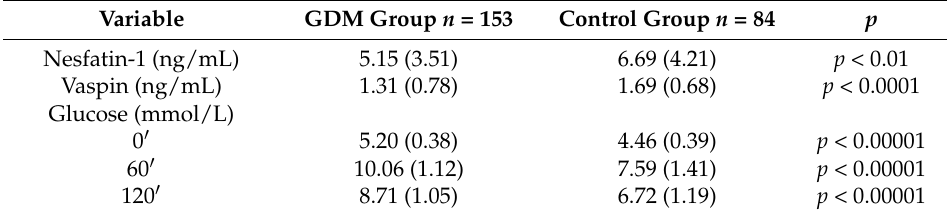
Table 2. Nesfatin-1, vaspin and glucose levels in GDM and control group (mean and standard deviation). Variable GDM Group n =